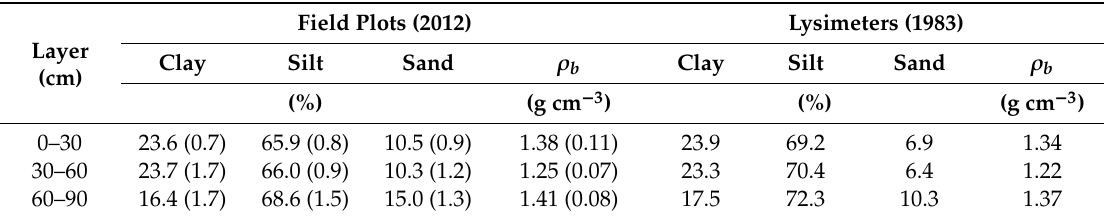
Table 1. Particle size distribution and bulk density of the field plots and lysimeters. When available, standard deviations are reported in parentheses.